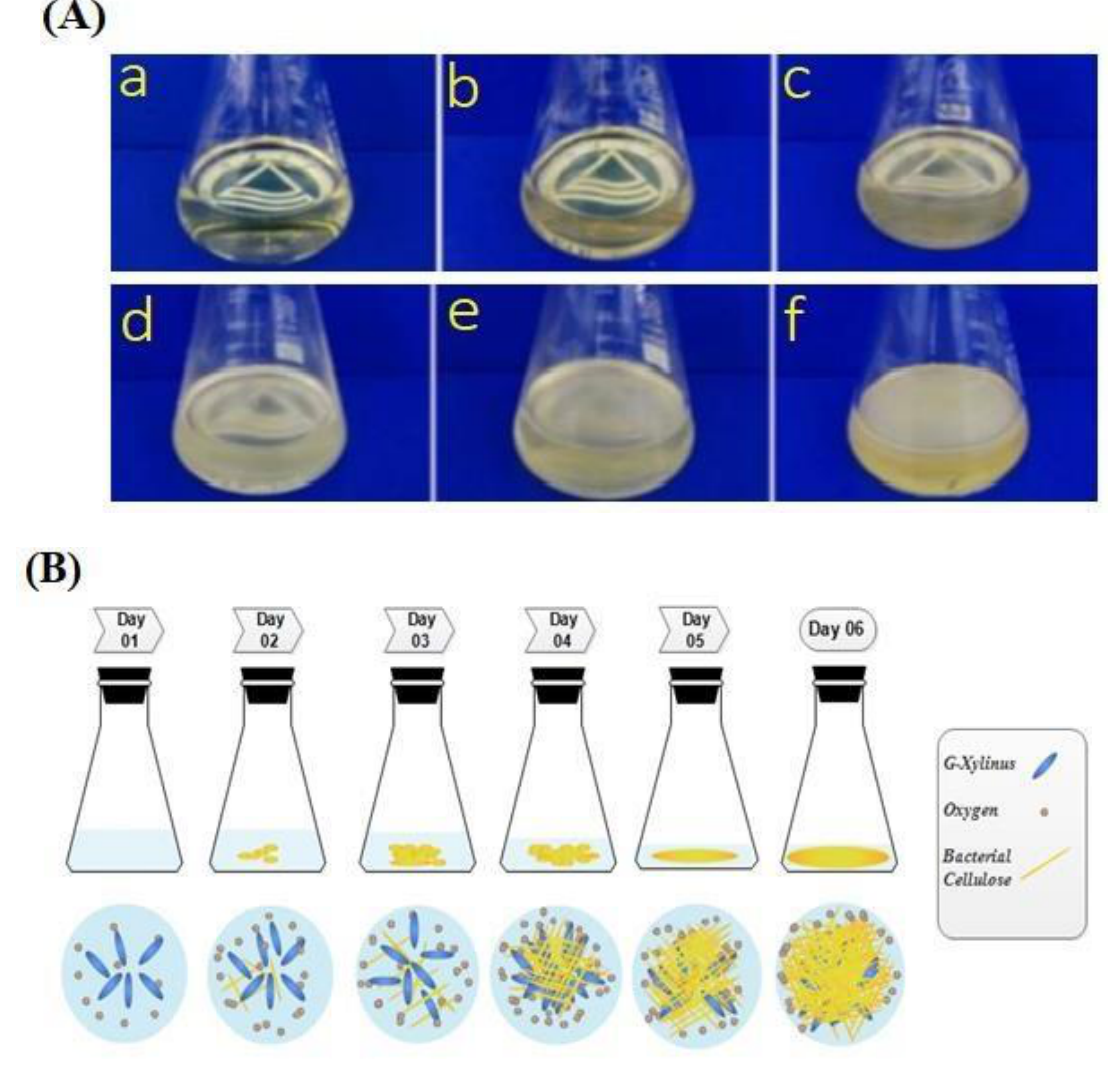
Figure 1. The synthesis of pure bacterial cellulose: ( A ) photographic presentation of six days (a: 1, b: 2, c: 3, d: 4, e: 5, f: 6) of bacterial cellulose cultivation; ( B ) schematic representation of pure bacterial